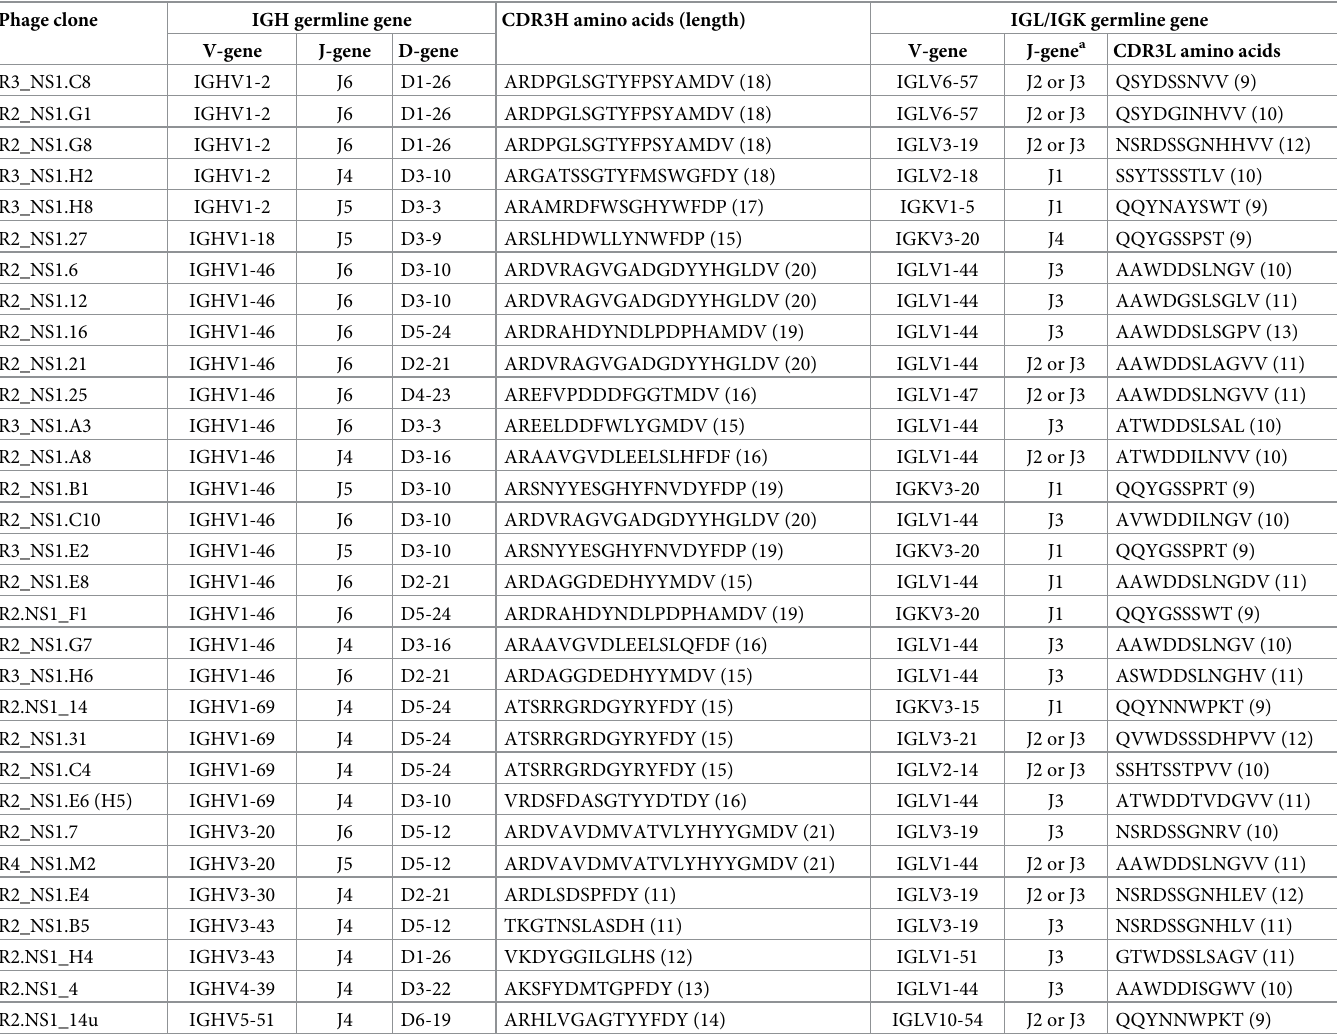
Table 1 (cont.) Immunoglobulin germline gene analysis of NS1 selective scFv phage clones. a Alignment of J-gene among mAbs matches more than one human germline gene sequences with equal percentage of